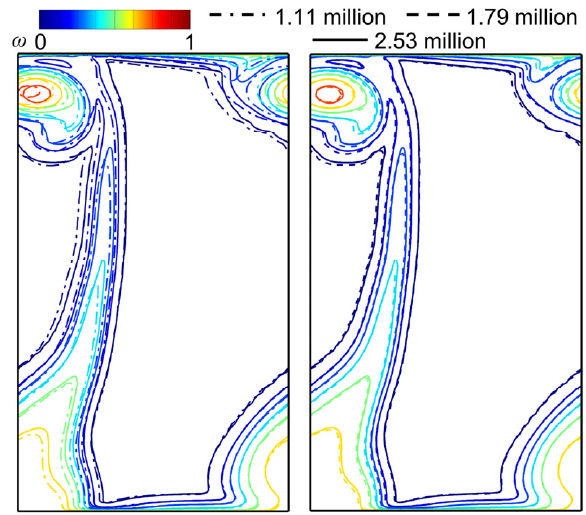
Figure 8. Computational grid of single passage.